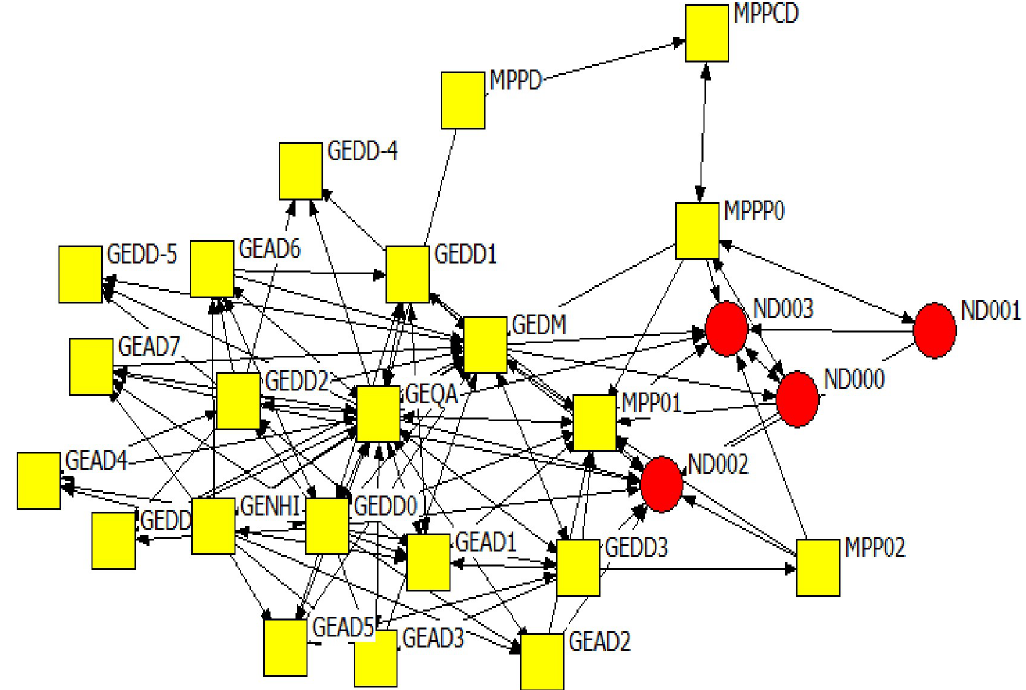
Fig 8. Mpumalanga province network: Receiving information. Colour and Shape of the nodes: red circle = National, yellow square = Provincial. Nodes label: ND = A label starting with ND refers to national actors, MP & GE = A label starting with MP or GE refers to provincial